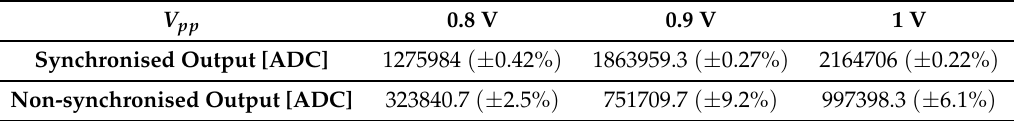
Table 2. Integrated ADC count values with standard deviation for different Peak-to-peak Voltages V pp for the non-synchronised readout and synchronised readout with the pulsed LD-1060. V pp 0.8 V